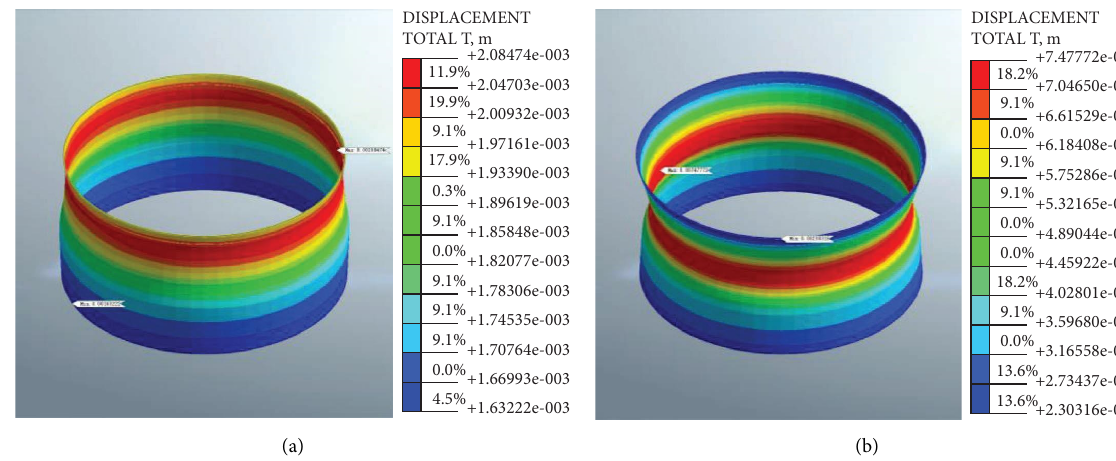
Figure 21: Working condition 3 wall deformation (a) without pore water pressure and (b) with pore water pressure applied.